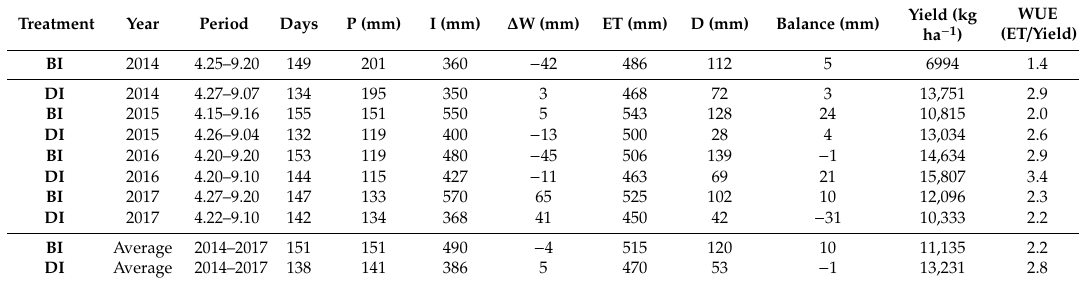
Table 7. Water budgets and water use e ffi ciencies (WUE) in a 1 m depth soil profile during 2014–2017 under two treatments. In the table, ∆ W (mm) represents the variation of soil water storage for 0–100 cm, while P the precipitation (mm), I the irrigation (mm), ET the evapotranspiration (mm), D the water drainage